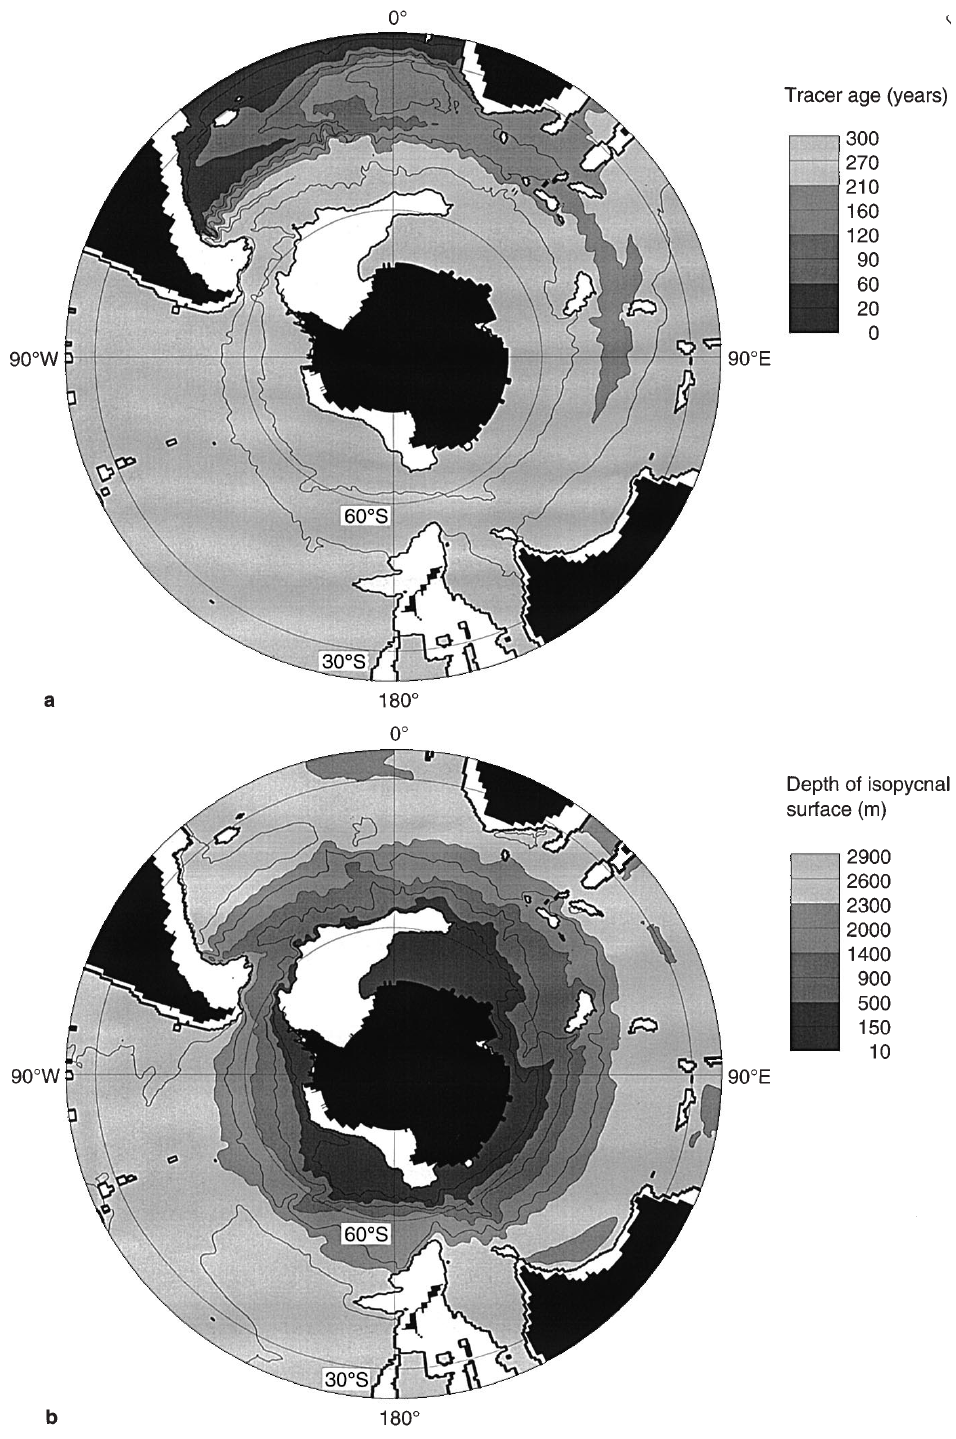
Fig. 4. The strong poleward flow of the East Australia Current at 155 (cid:14) E is seen to move around Tasmania and westwards into the Indian Ocean. The westwards transport of this current at 146 (cid:14) E is 4 Sv. Fine (1993) suggests such a pathway is consistent with salinity,